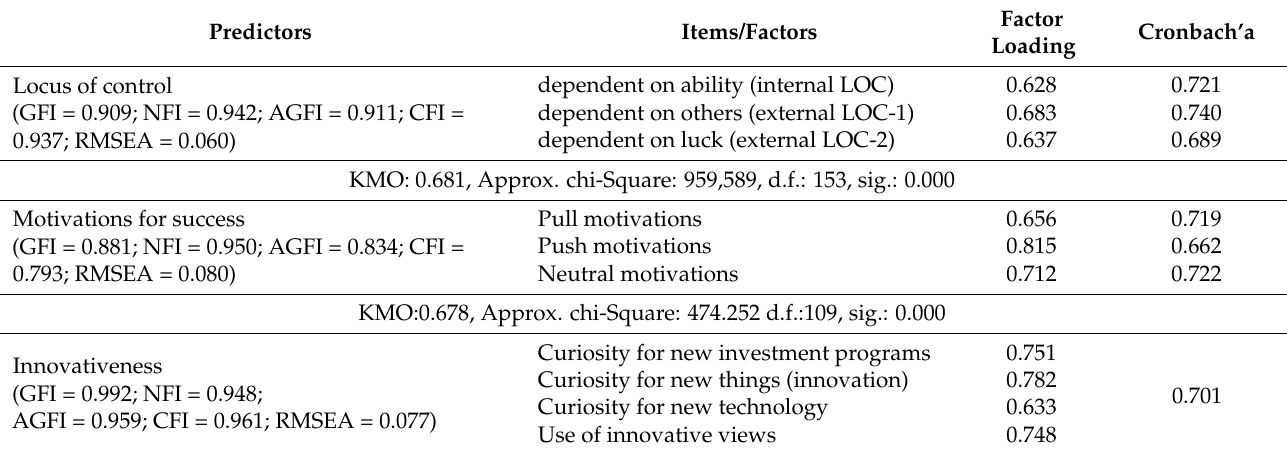
Table 3. EFA and CFA